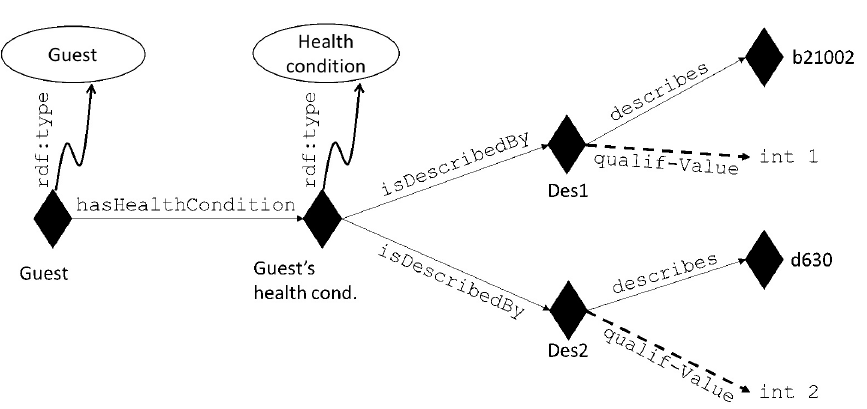
Figure 4. An example of the modelling of a guest’s health condition; individuals are represented with diamonds, concepts are represented with circles, and roles are represented with arrows (dashed arrows indicate datatype properties, full-line arrows represent object properties). The type of an individual is stated with a curved